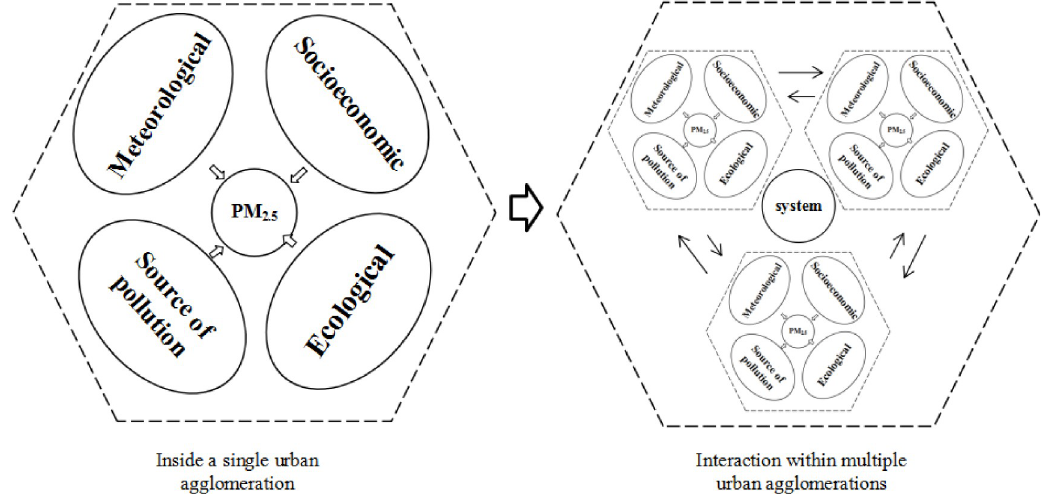
Fig 2. Interaction between factors affecting PM 2.5 pollution within individual urban agglomerations and between multiple urban agglomerations.